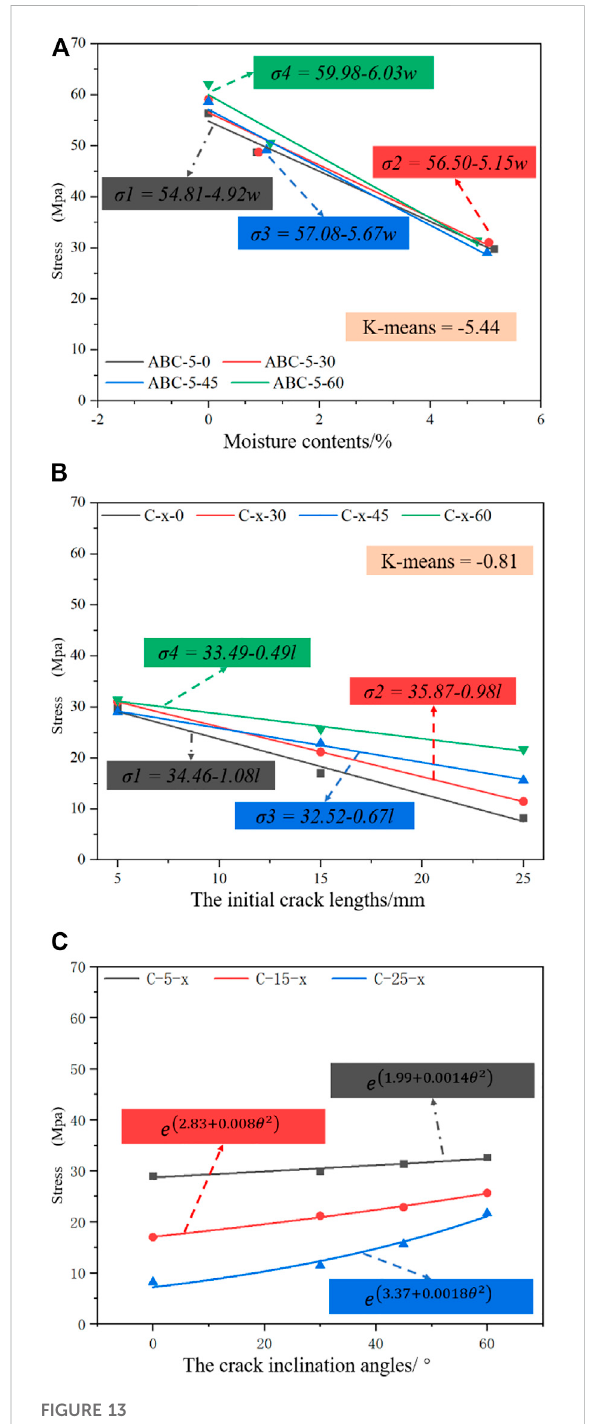
FIGURE 13 Characteristic curves of compressive strength of rock samples under different conditions; (A) Fitting curve of initial crack lengths and compressive strength in saturated state; (B) Fitting curve of rock moisture content and compressive strength; (C) Fitting curve of crack inclination angles and compressive strength in saturated